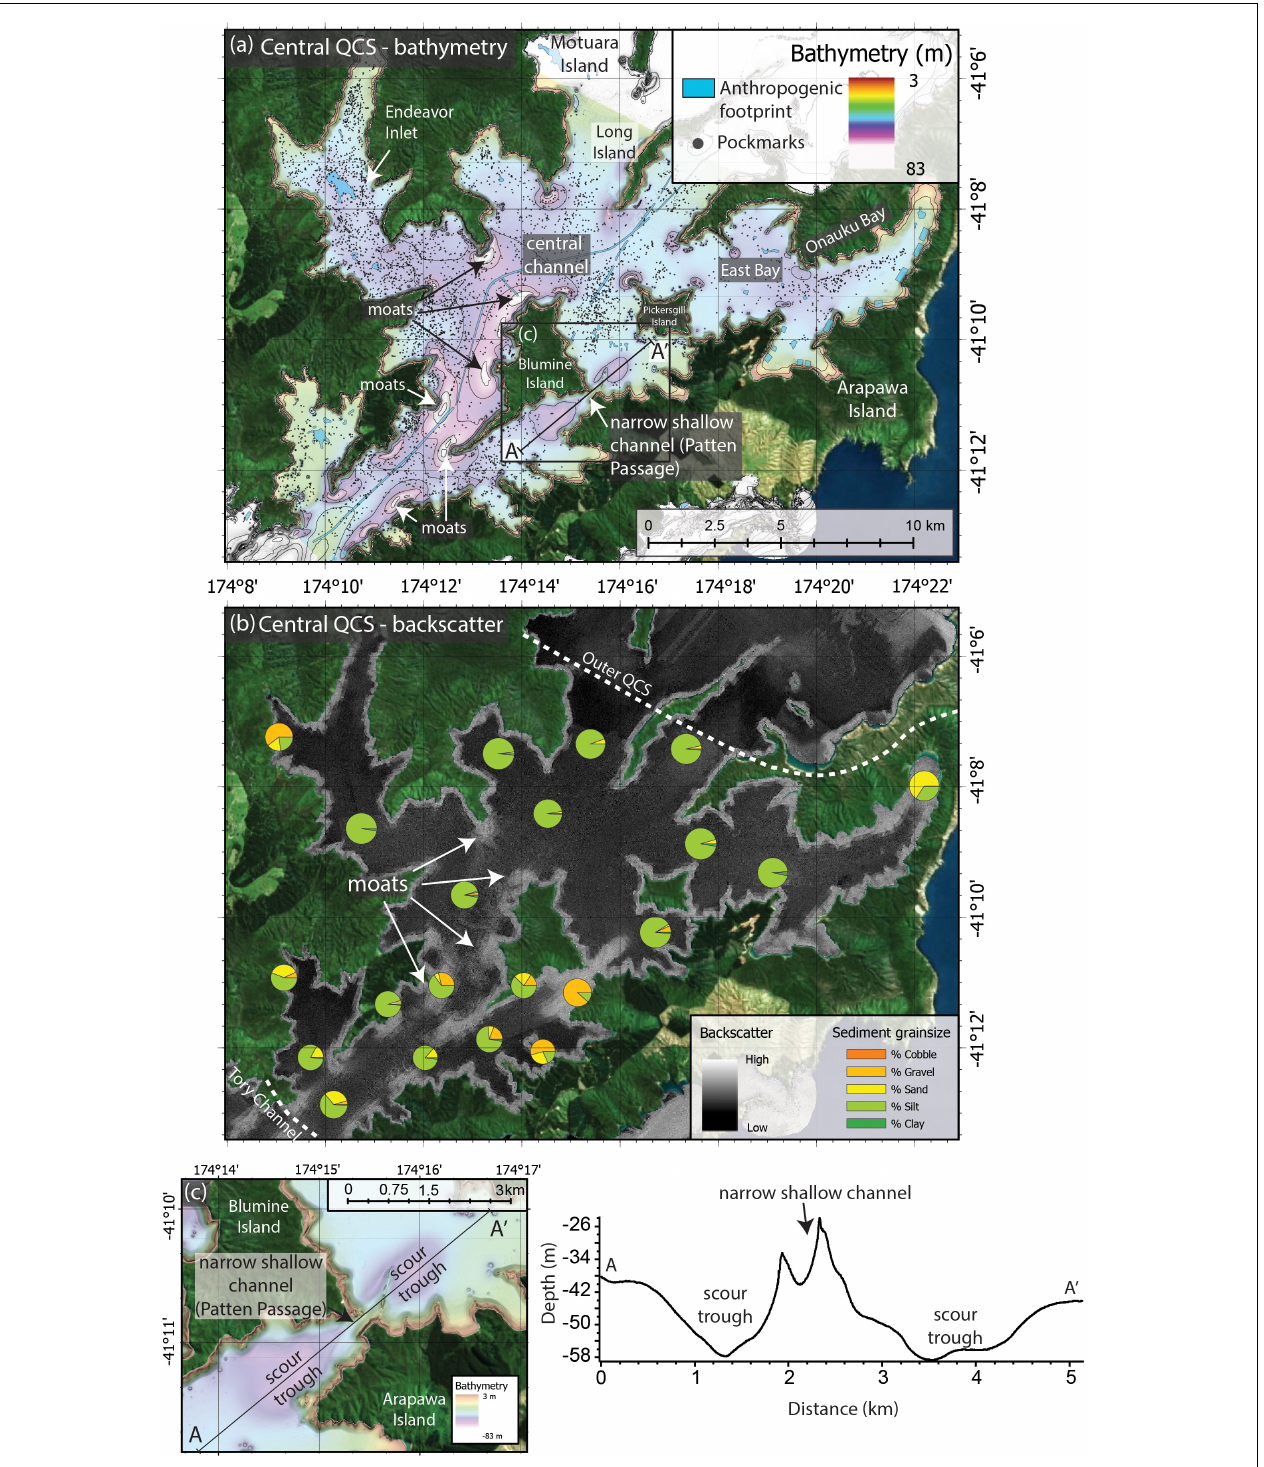
FIGURE 5 | (a) Gridded 2-m bathymetry overview of the central QCS. For location of central QCS see Figure 1b . Features described in the main text are labeled. Blue transparent polygons are regions affected by anthropogenic activities, black points are locations of pockmarks, black lines are bathymetric contours at 10 m intervals. Black square shows location of inset (c). (b) 0.5 m seafloor backscatter mosaic in the central QCS. For clarity, pie charts show a subset of sample grain-size distributions that are representative of the trends observed in the complete dataset (for locations and grainsize distribution data for all samples collected